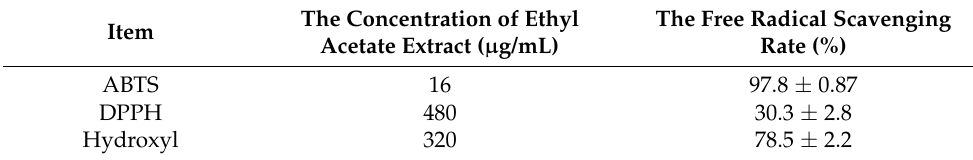
Table 3. Free radical scavenging rate of ethyl acetate extract of strain Y4. The Concentration of Ethyl Item Acetate Extract ( µ